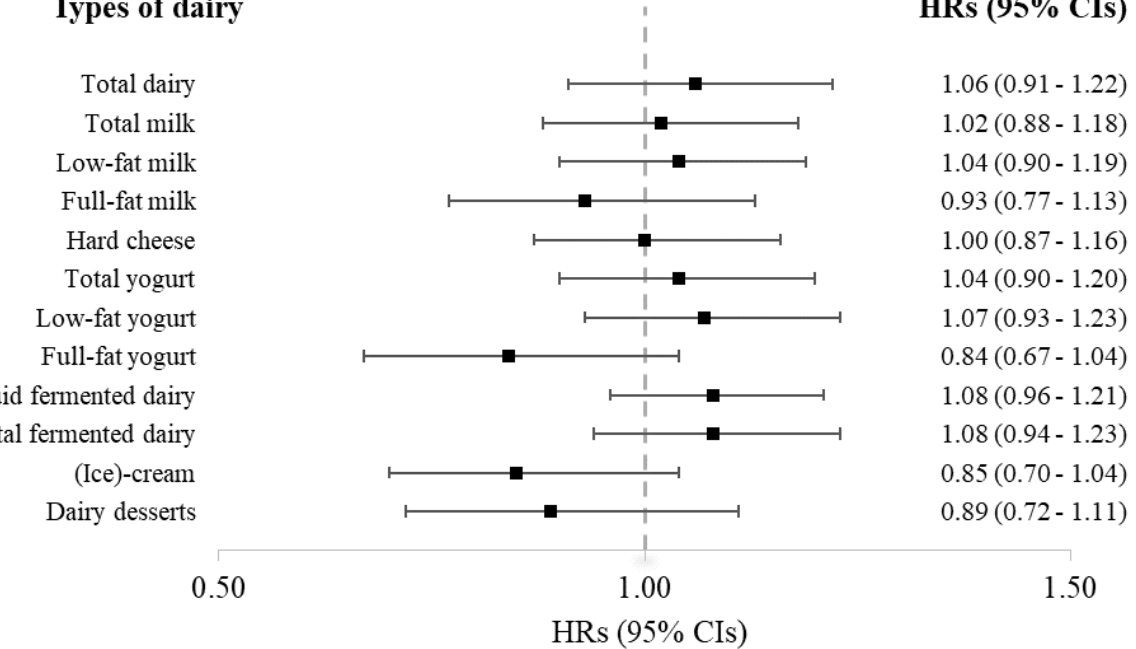
Figure 1. Hazard ratios (HRs) and 95% confidence intervals (95% CIs) for type 2 diabetes per 1-SD increment in (types of) dairy consumption (g/d) in 3401 patients from the Alpha Omega Cohort. Dairy intakes were adjusted for total energy intake. Multivariable models were adjusted for age (y), sex, total energy intake (kcal/d), smoking (3 categories), physical activity (3 categories), educational level (3 categories), alcohol intake (4 categories), family history of diabetes, BMI (kg/m2) and dietary intakes (g/d) of whole grains, refined grains, potatoes, fruit, vegetables, total red and processed meat, sugar-sweetened beverages, coffee, tea and other dairy products, except for total dairy (model 4).